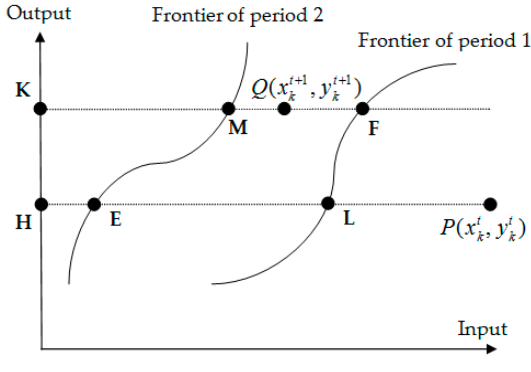
Figure 2. Catch-up terms [18].